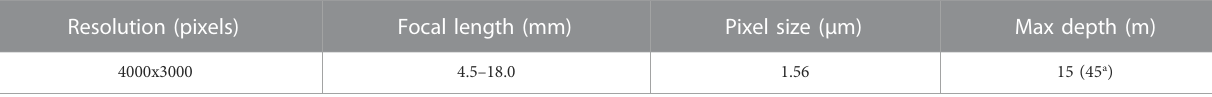
TABLE 4 Main technical speci fi cations of the Olympus TG-6 camera. Resolution